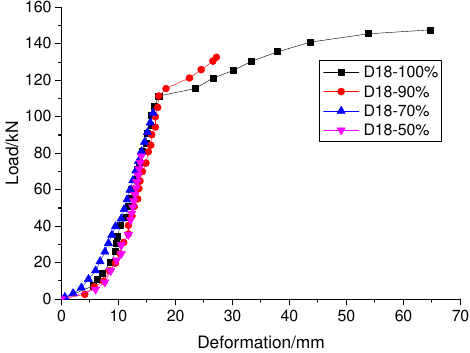
Figure 9. Load-displacement curves for D 18 GSS connectors at different compactness.